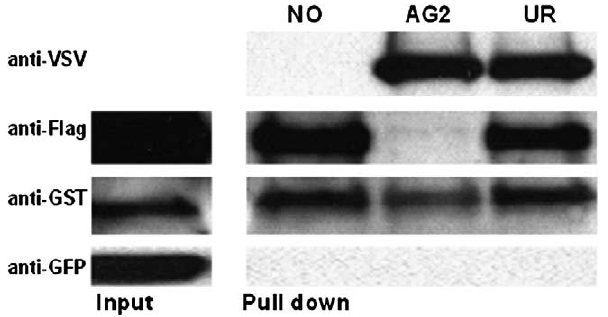
Fig. 5. VHH-AG2 competes for pVHL binding to HIF-1 α . GST pull down for VHL-GST and FLAG-HIF-1 α . Pull downs were incubated with antibodies, VHH AG-1N2C-VSV an AG2 bivalent or an unrelated (UR) VSV tagged bivalent. Supernatant of the pull down was immunoblotted for VSV as a control for antibodies added. Input and pull down was immunoblotted for H2B-GFP, FLAG-HIF-1 α and VHL-GST.